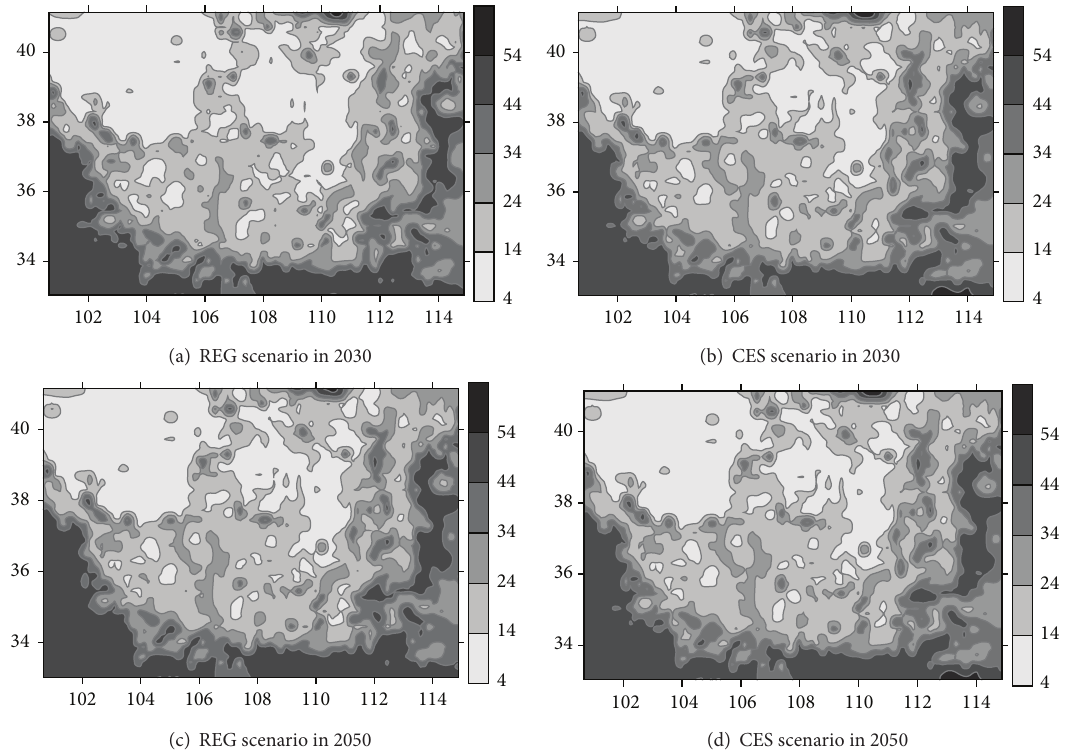
Figure 4: Latent heat flux changes under different scenarios in 2030 and 2050 in the semiarid grassland area of China (unit: W/m 2 ).